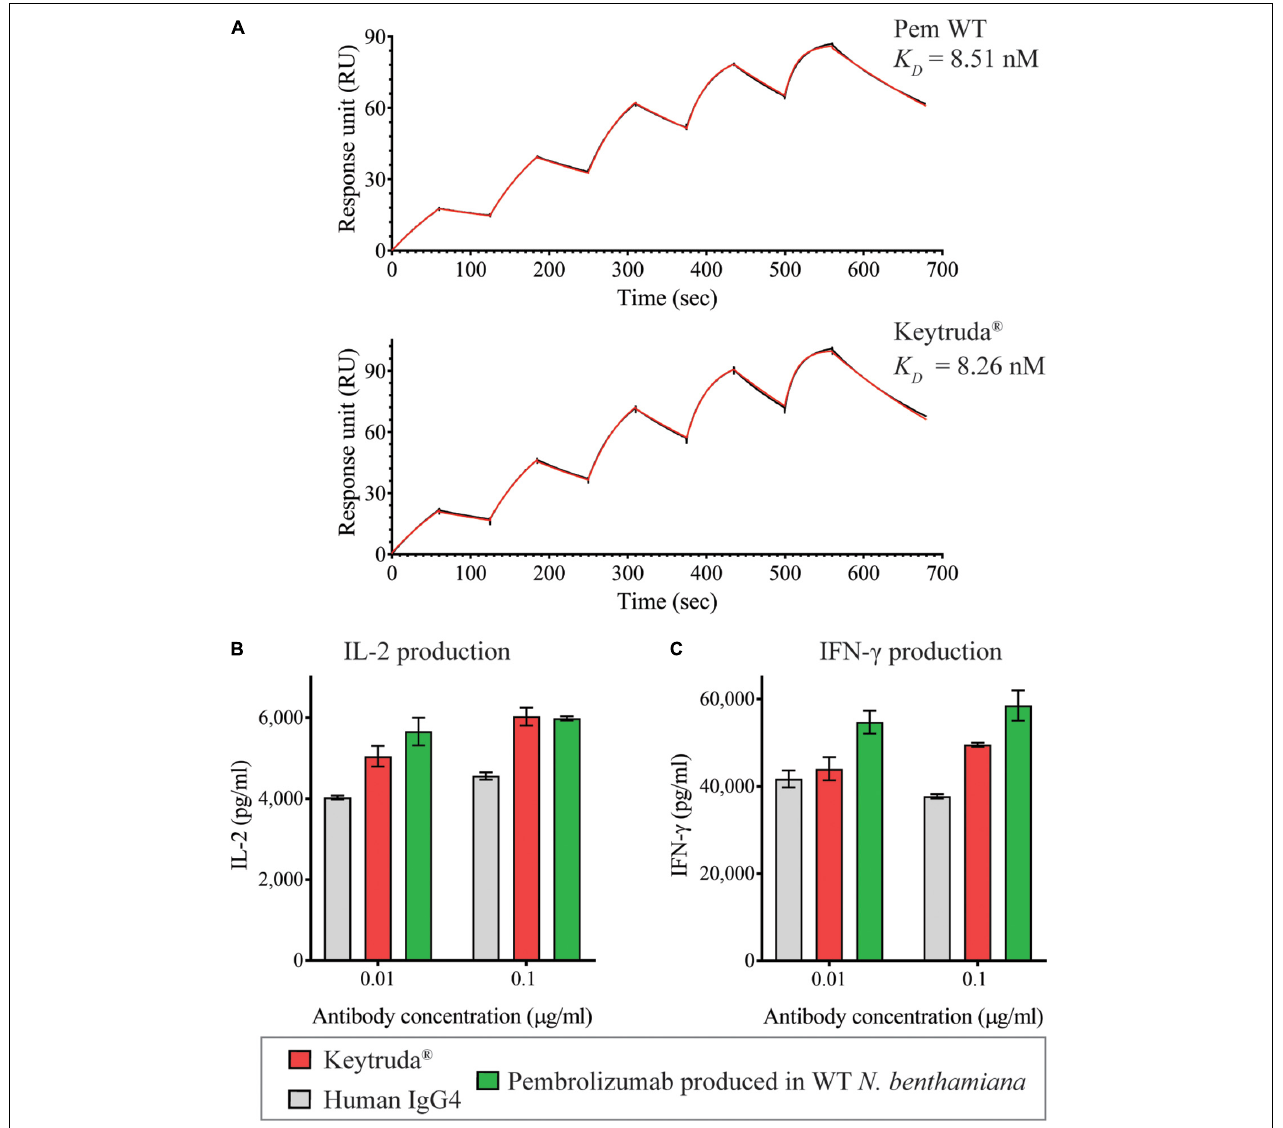
FIGURE 5 | Functional characterization of plant-produced Pembrolizumab. (A) Binding kinetics data of plant-produced Pembrolizumab and Keytruda R (cid:13) with human PD-1 analyzed by SPR. PBMCs from healthy donors were stimulated with 1 ng/ml SEB in the presence of antibodies at 0.01 and 0.1 µ g/ml. The secretion levels